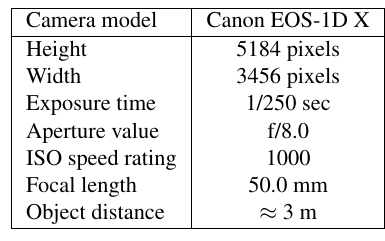
Table 1. The camera setting for data